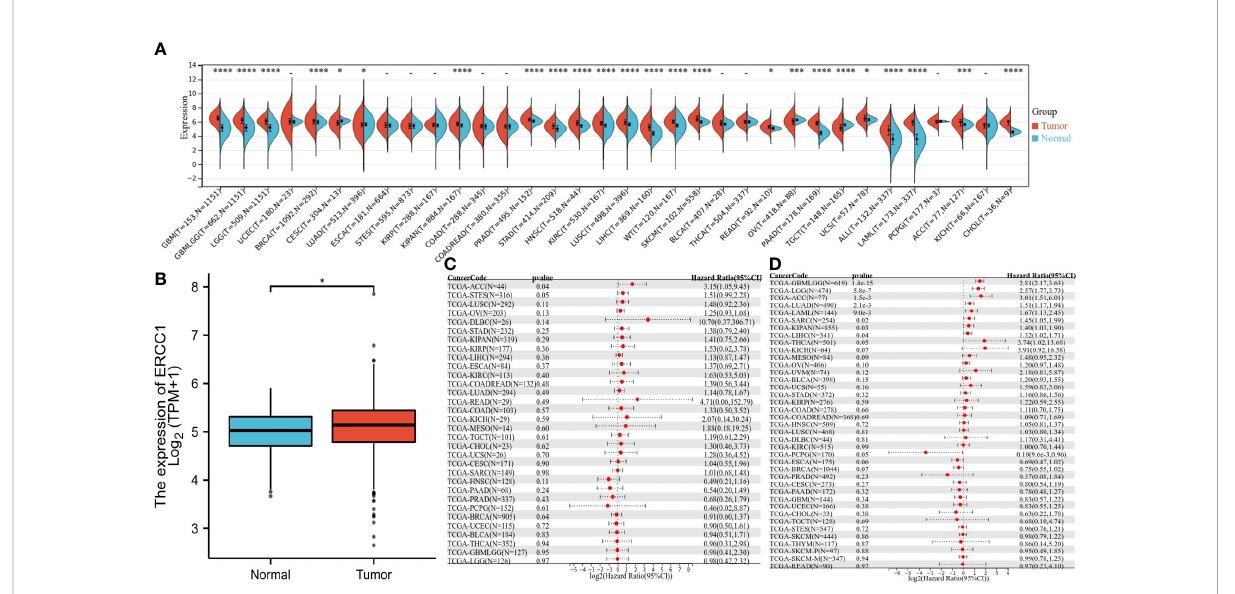
FIGURE 2 The expression of ERCC1 and survival analysis in pan-cancers, (A) ERCC1 expression in pan-cancers. (B) ERCC1 expression in breast cancer. (C) Univariate survival analysis in pan-cancers [disease-free survival (DFS]). (D) Univariate survival analysis in pan-cancers [overall survival (OS)]. *P < 0.05; ***P < 0.005; ****P <